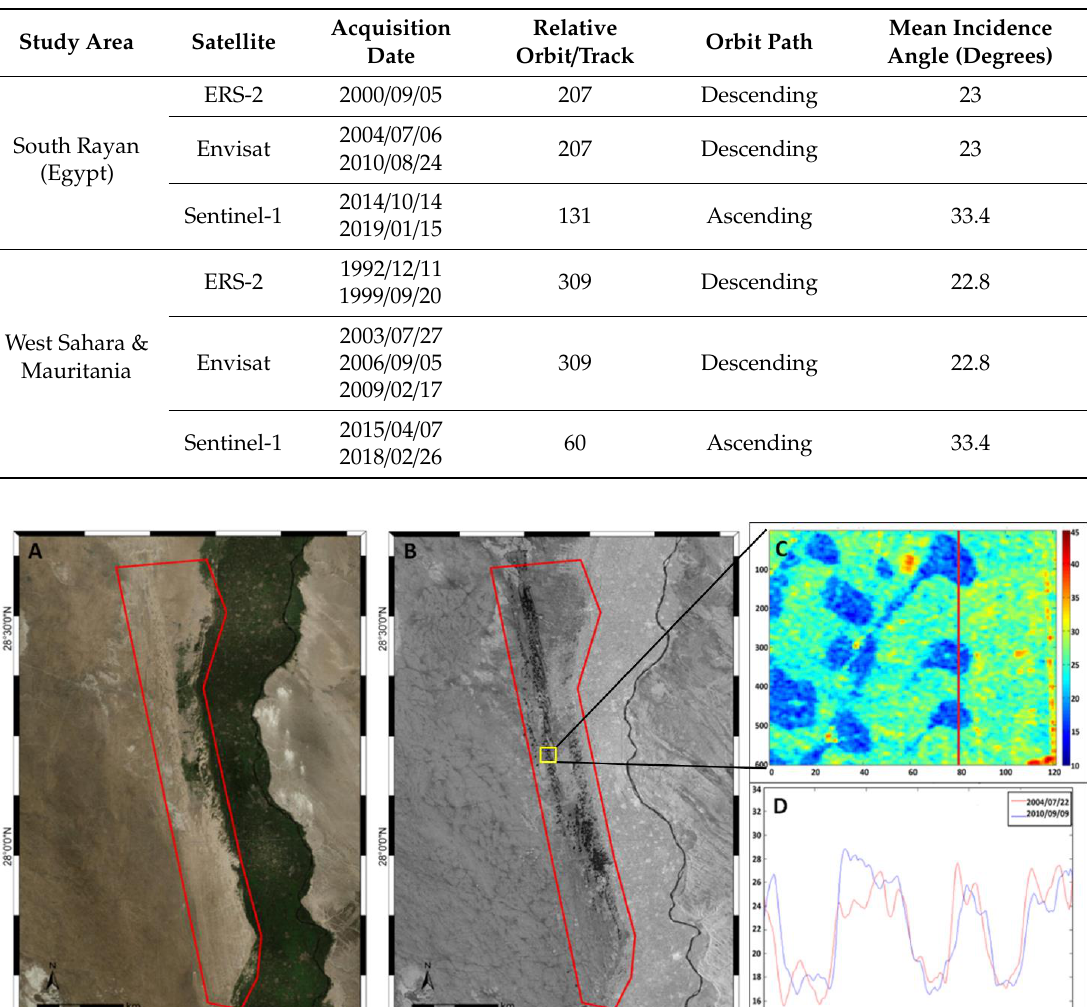
Table 1. Satellite data, acquisition dates, orbit pass, relative orbit and mean incidence angle in decimal degrees.